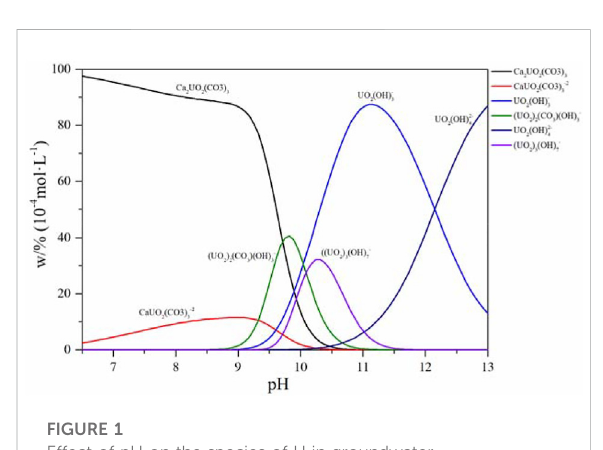
FIGURE 1 Effect of pH on the species of U in